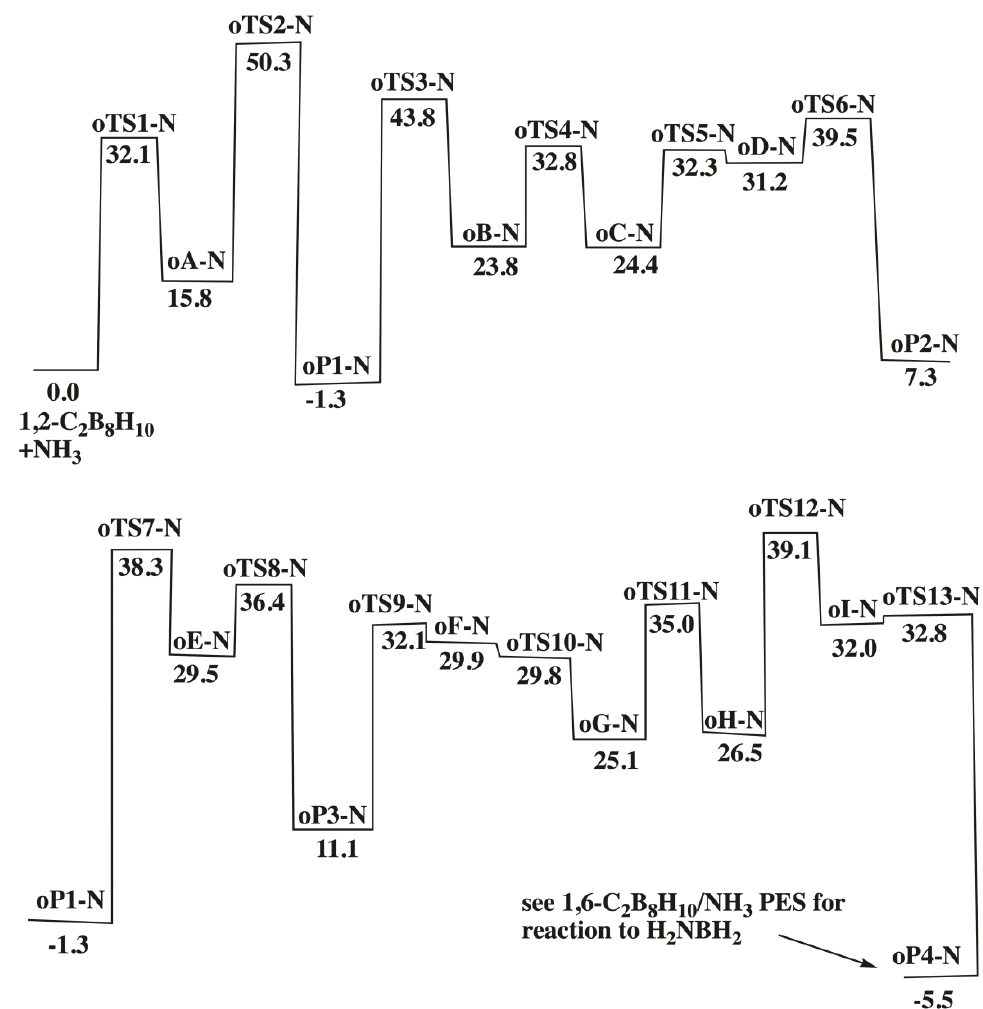
Figure 4. Relative free energies (kcal · mol − 1 ) of the individual stationary points on the PES of the reaction of closo -1,2-C 2 B 8 H 10 with NH 3 (see Table 1 and Methods for details).